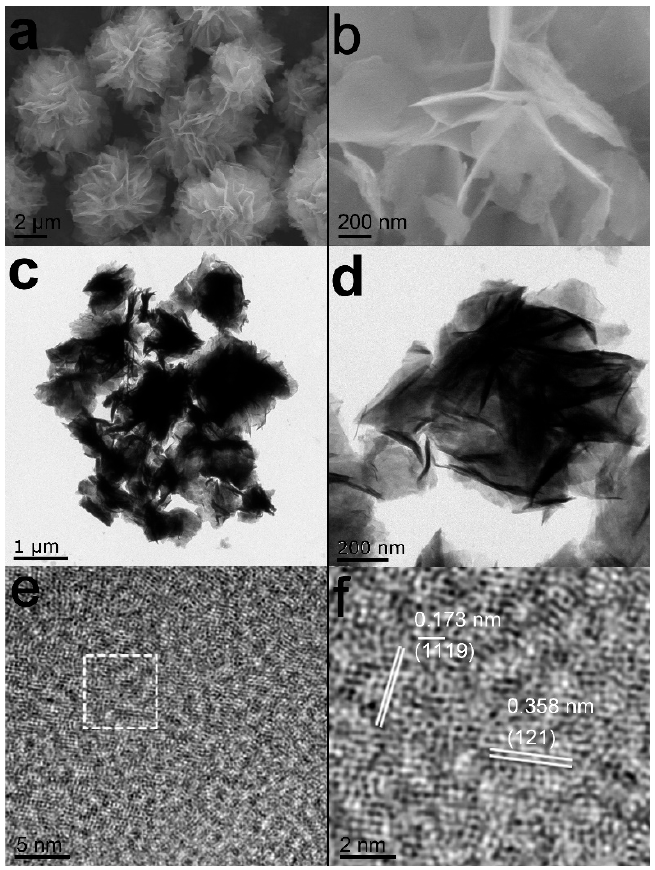
Figure 2. Low- and high magnification FE-SEM images ( a , b ), TEM images ( c , d ) and typical HRTEM images ( e , f ) of Nb 2 O 5 micro-flower. Materials 2021 , 14 , x FOR PEER REVIEW